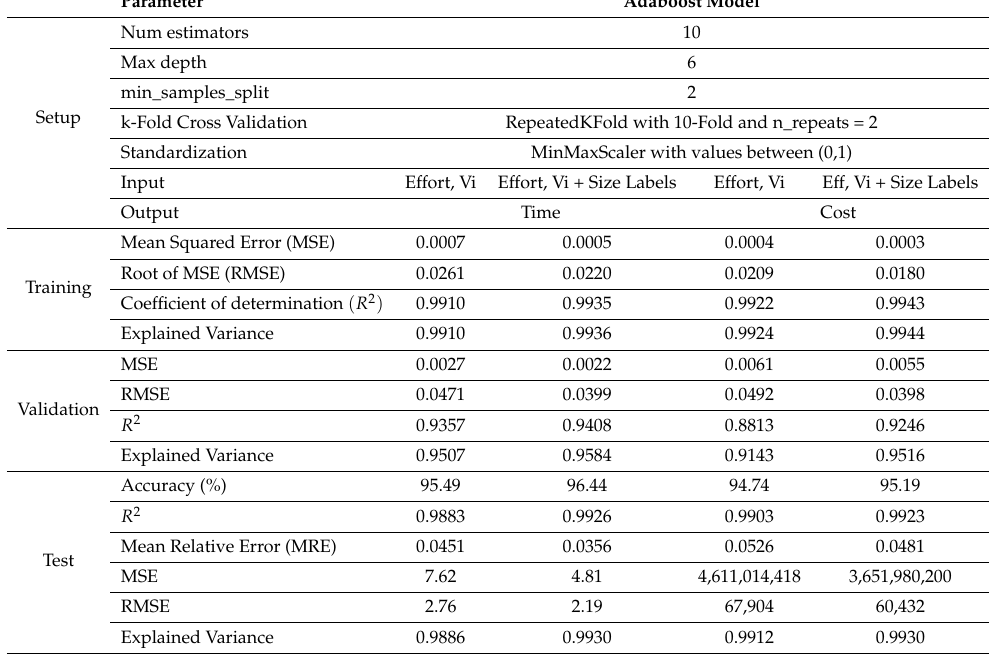
Table 12. Grouped results of AdaBoost algorithm for unlabeled and labeled data.